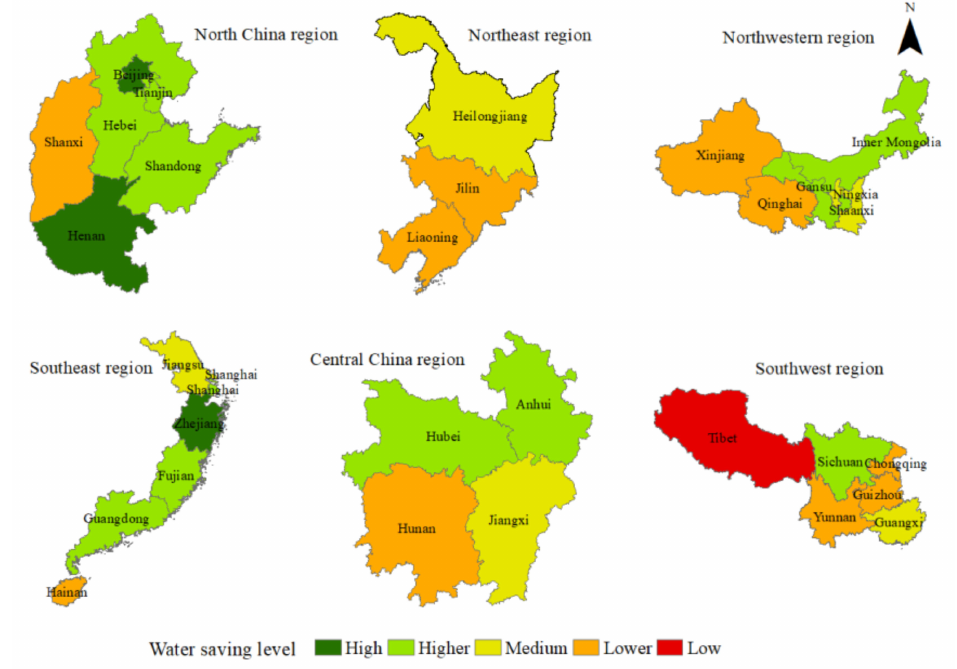
Figure 7. Spatial distribution of regional water-saving levels by